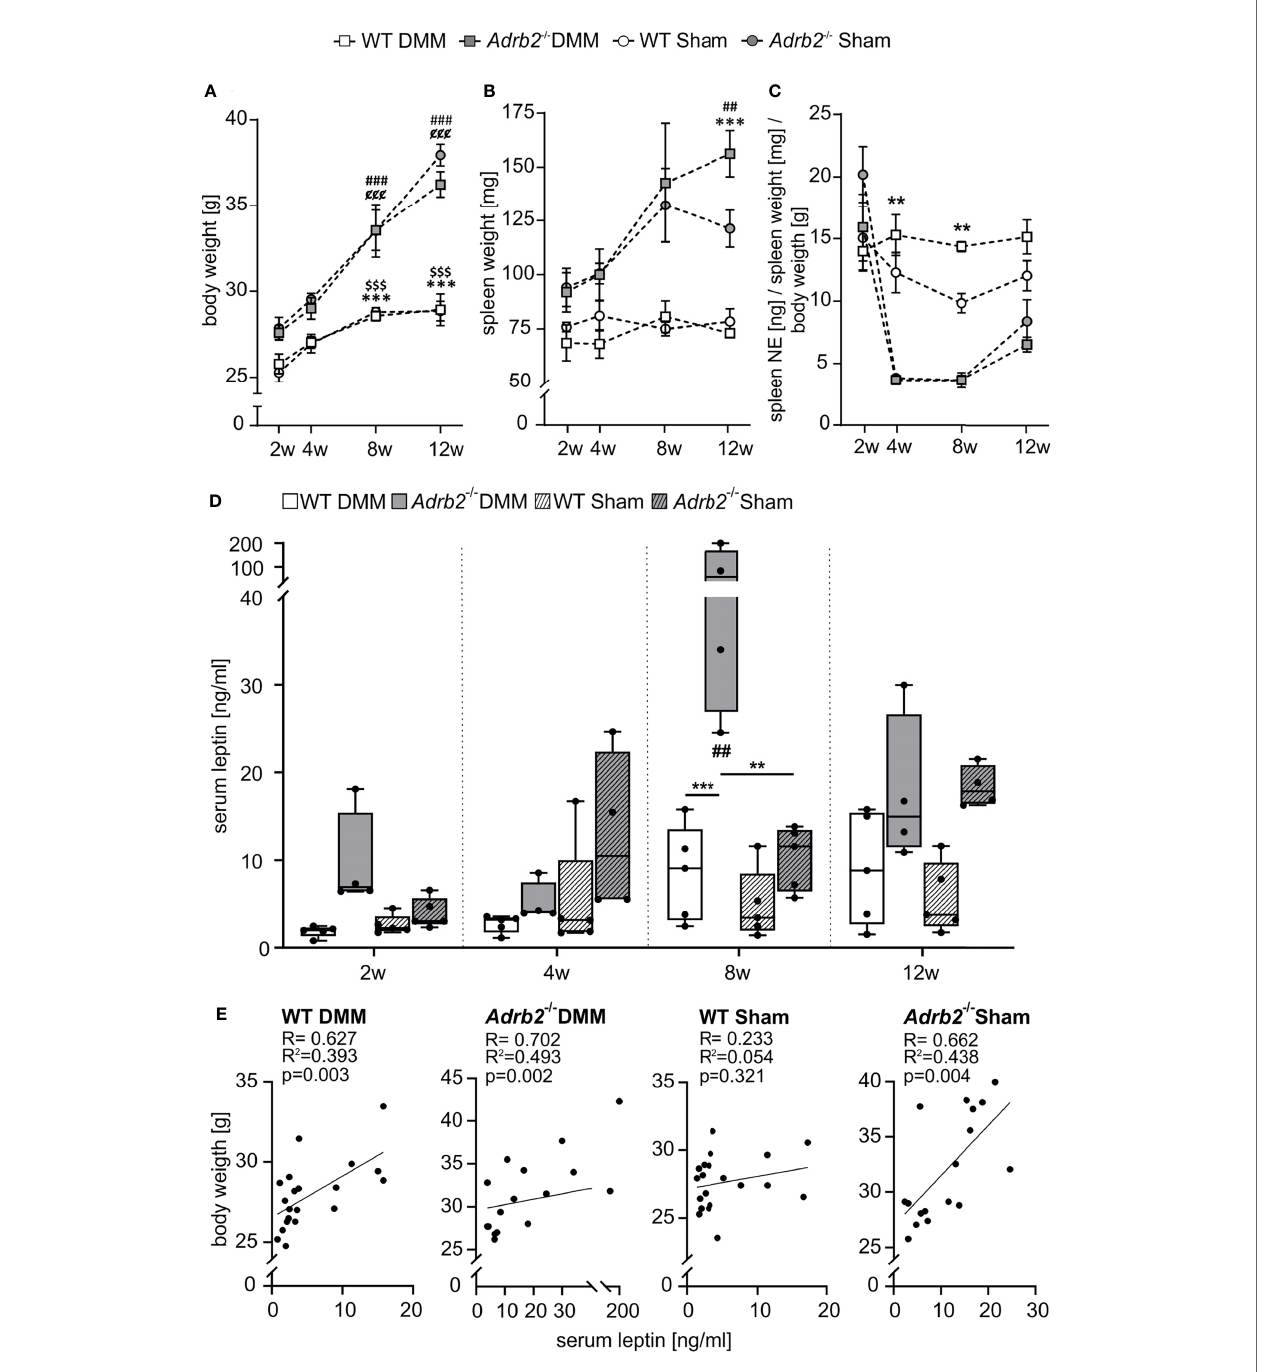
FIGURE 6 | Body weight, spleen weight, splenic NE concentration and serum leptin level. (A) Body weight data are represented as means +/- SEM (n=8-10 per group). Signi fi cant p-values are presented as ### p ≤ 0.001 when compared to 2 weeks Adrb2 -/- DMM; $$$ p < 0.001 when compared to 2 weeks WT Sham; ¢¢¢ p ≤ 0.001 when compared to 2weeks Adrb2 -/- Sham; ***p ≤ 0.001 when WT DMM compared to Adrb2 -/- DMM; $$$ p ≤ 0.001 when WT Sham compared to Adrb2 -/- Sham. (B) Spleen weight data are represented as means +/- SEM (n=8-10 per group). Signi fi cant p-values are presented as ## p ≤ 0.01 when compared to 2 weeks Adrb2 -/- DMM; ***p ≤ 0.001 when WT DMM compared to Adrb2 -/- DMM. (C) Relative splenic NE concentration data are represented as means +/- SEM (n=3 per group). Signi fi cant p-values are presented as **p ≤ 0.01 when WT DMM compared to Adrb2 -/- DMM; ¢ p ≤ 0.05, ¢¢¢ p ≤ 0.001 when compared to 2weeks Adrb2 -/- Sham. (D) Serum leptin concentration data are presented as box plots with whiskers. Each black circle represents an individual mouse (n=5 per group). Signi fi cant p-values are presented as **p ≤ 0.01, ***p ≤ 0.001 for comparisons between groups. (E) Linear regression of serum leptin concentrations and body weight in WT and Adrb2 -/- mice 2, 4, 8, and 12 weeks after DMM and Sham